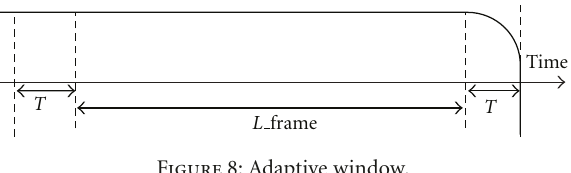
Figure 8: Adaptive window.